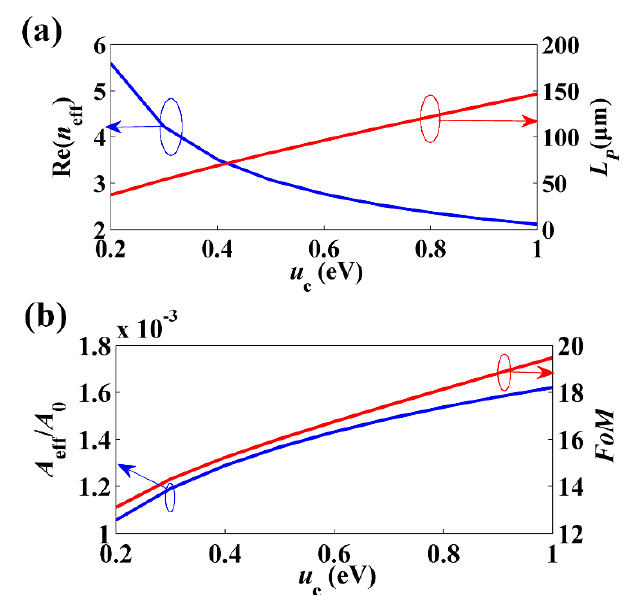
Figure 6. ( a ) Real part of n eff and L P , and ( b ) A eff/ A 0 and FoM as a function of chemical potential u c at f 0 = 3 THz. Here a = 0.5 μm , b / a = 2, ε 1 = 2.25, and ε 2 = 1.